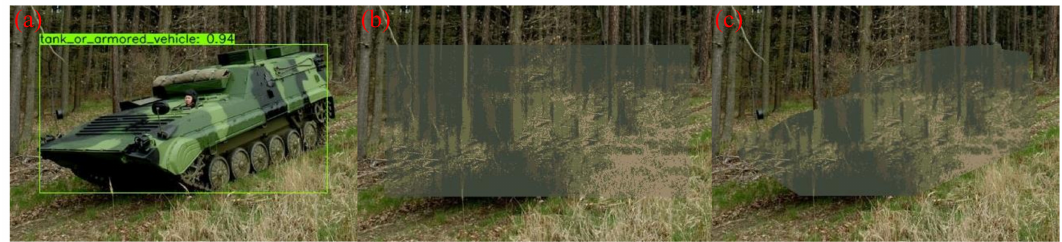
Figure 11. Adaptive digital camouflage texture. ( a ) Original image; ( b ) Rectangular texture area; ( c ) Camouflaged images using